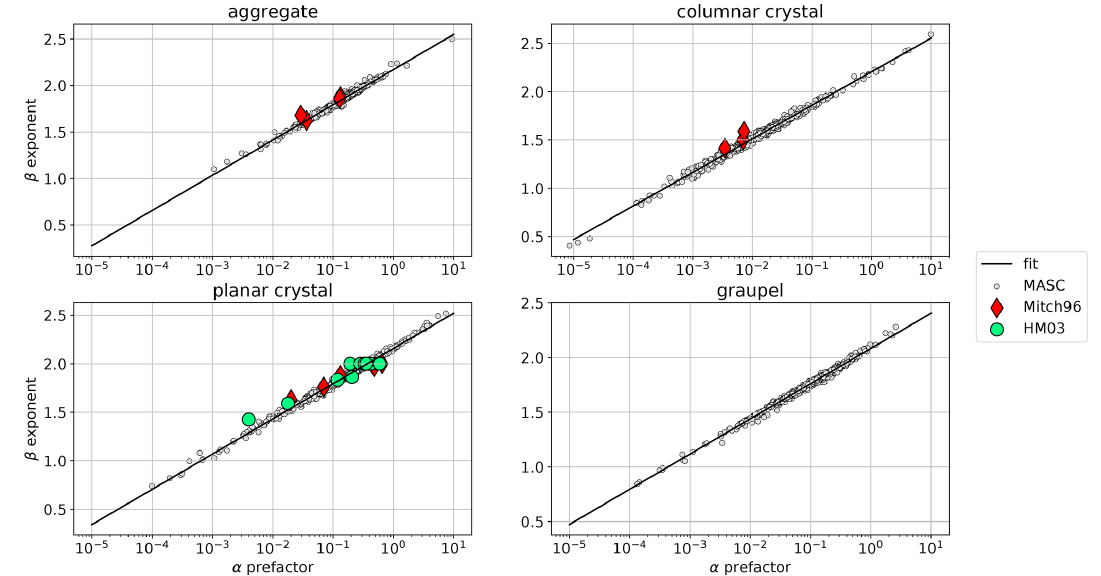
Figure B4. Same as Fig. B3 but for area–size relation.